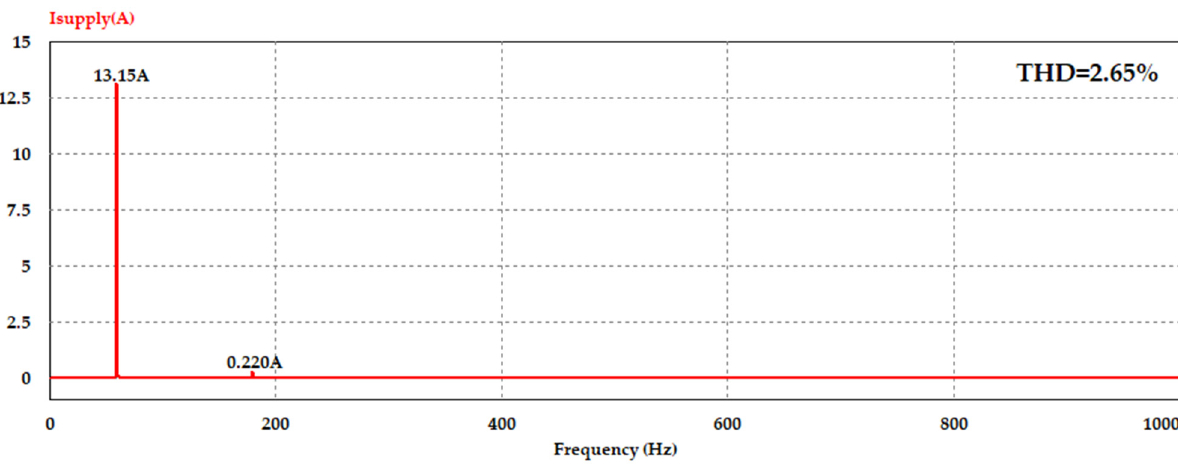
Figure 22. Supply current frequency spectrum for the interleaved CCM PFC.